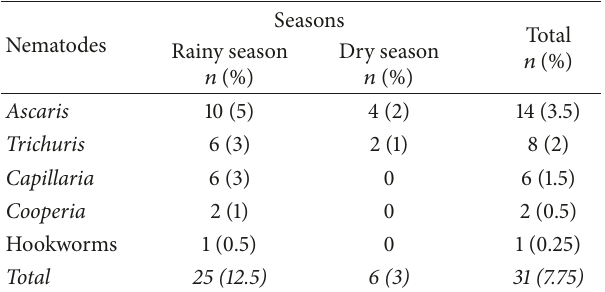
Table 2: Type and frequency of nematode eggs recorded in rainy and dry